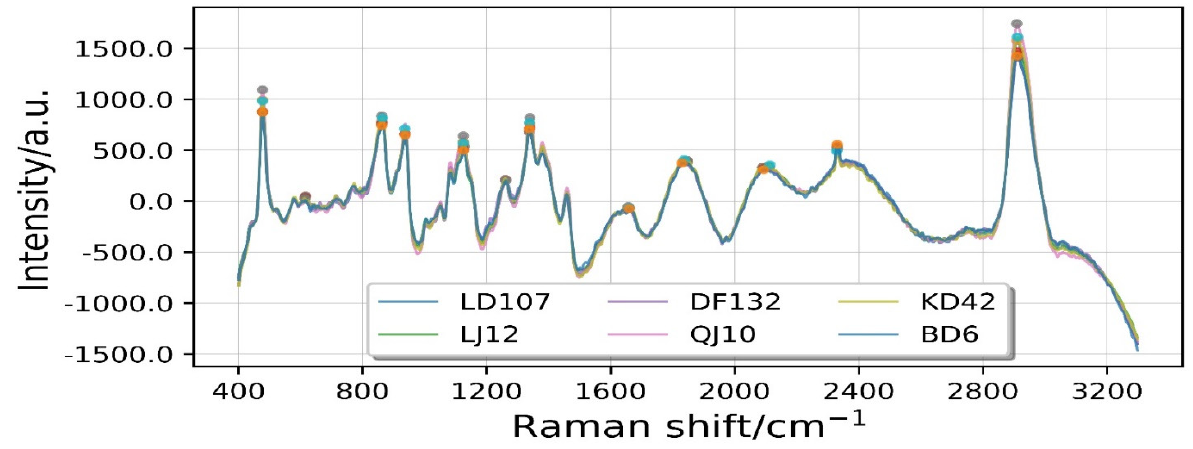
Figure 3. The peak crest of Raman spectrum was extracted by filtering difference.